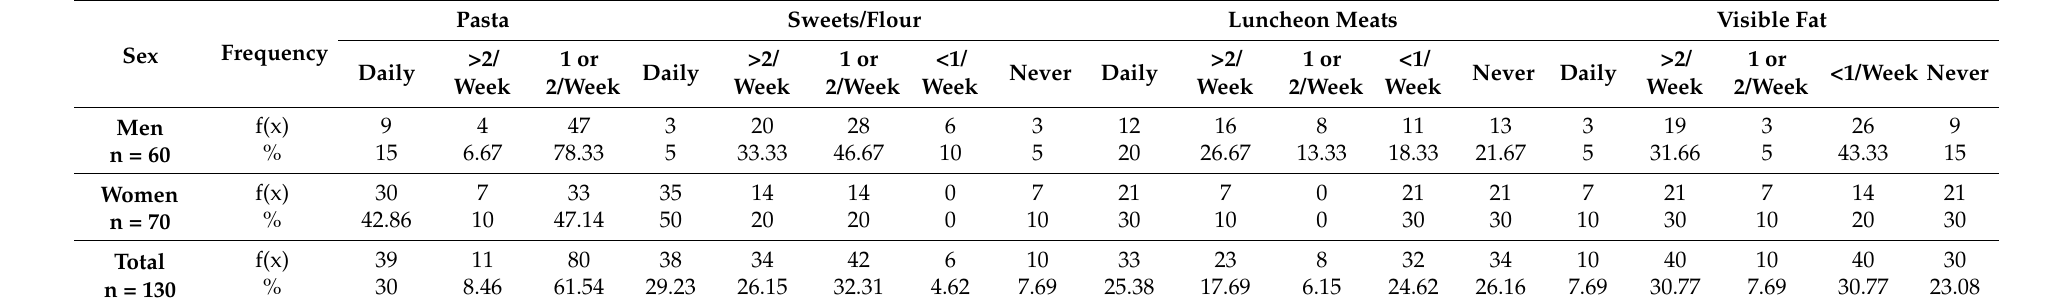
Table 5. Consumption frequency of food groups according to food intake. Classification in accordance with dietary recommendations for older adults. Occasionally consumed